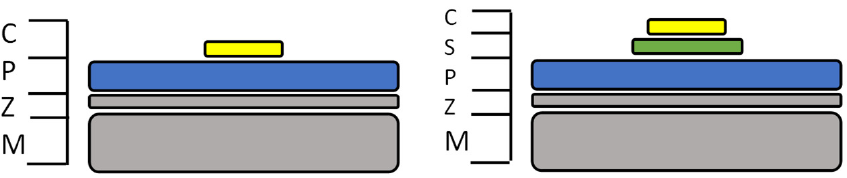
Figure 4. Two tag systems NS, no substrate, ( left ) and S, substrate, ( right ) showing the copper sensor (C), the substrate layer (S), the paint system (P) the zinc galvanized layer (Z) and the steel metal substrate layer (M).